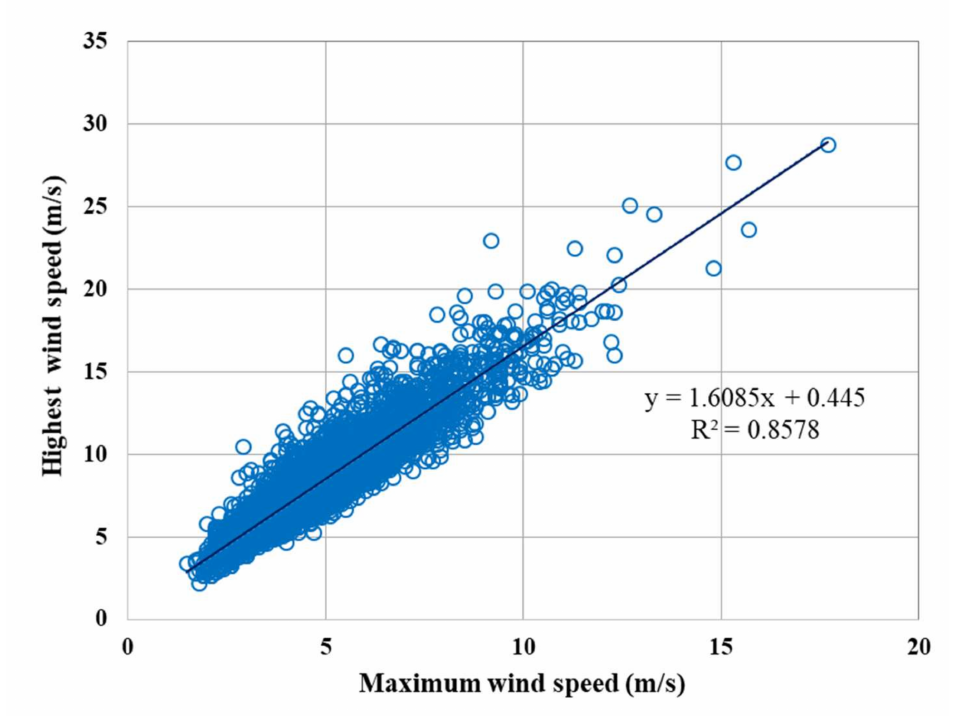
Figure 2. Corresponding relation between maximum wind speed and highest wind speed from 2005 to 2015 in the Northeast and North China